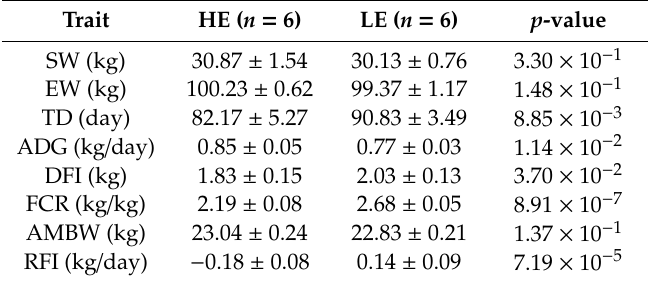
HE = high e ffi ciency. LE = low e ffi ciency. n = number of pigs. SW = starting weight. EW = ending weight. TD = testing days. ADG = average daily gain over the assessed feeding period. DFI = daily feed intake. FCR = feed conversion ratio. AMBW = average metabolic body weight gain. RFI = residual feed intake. p -value was calculated